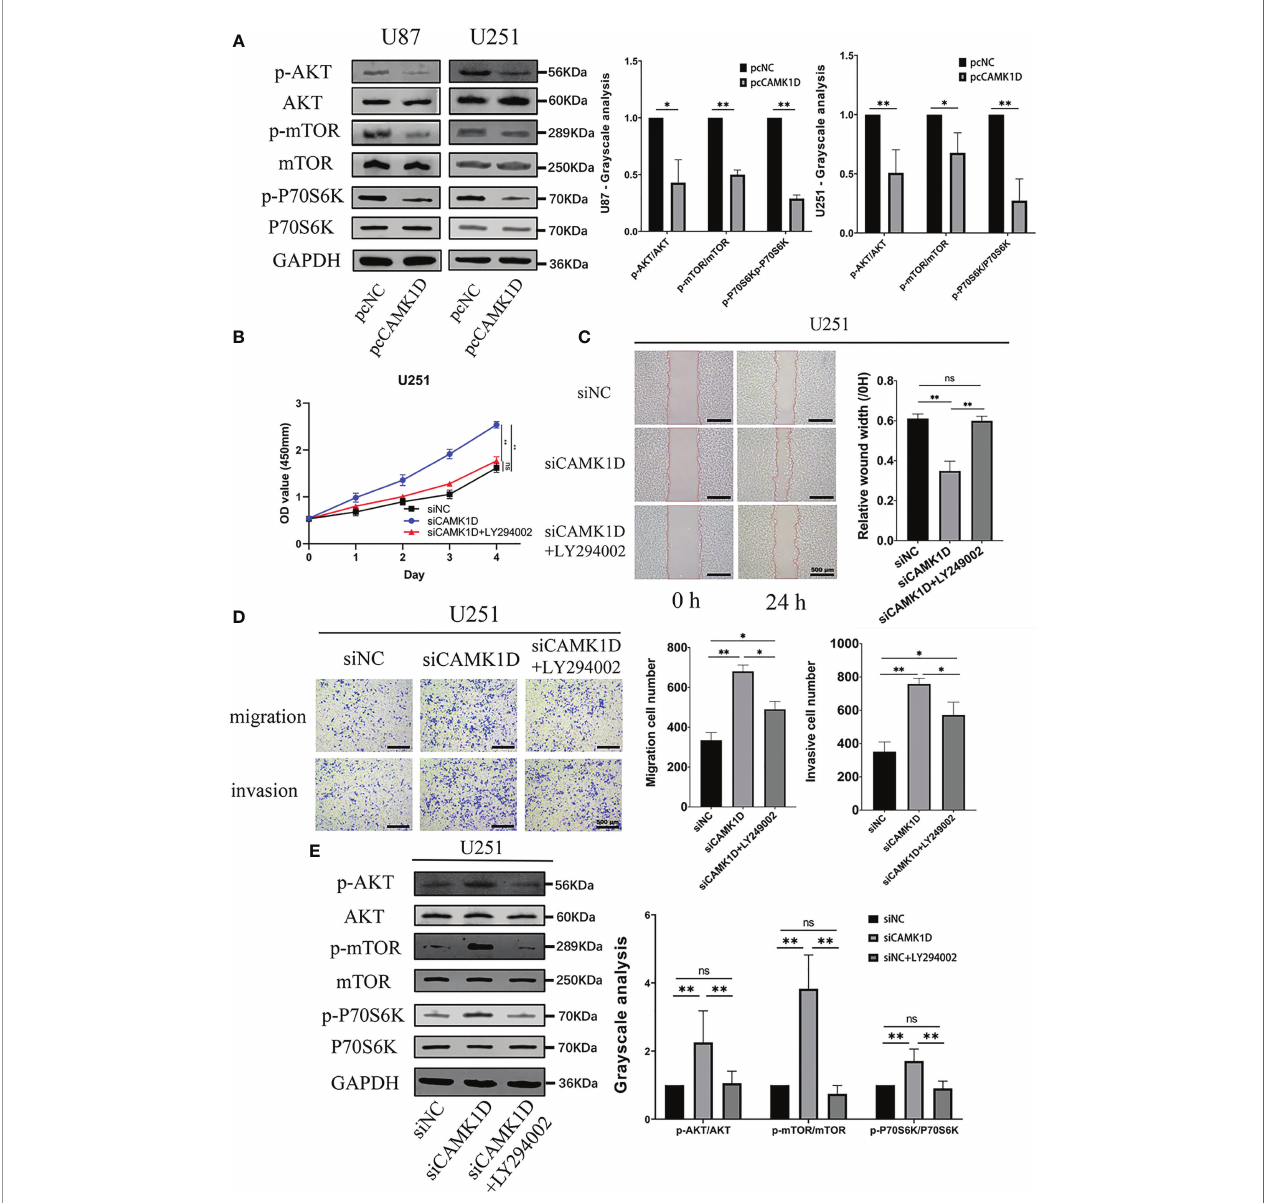
FIGURE 7 | CAMK1D level changes on the PI3K/AKT/mTOR pathway. (A) Compared with the control, the expression of p-AKT and p-mTOR was signi fi cantly decreased after CAMK1D overexpression using pcCAMK1D plasmid construction in U87 and U251 cells. (B – D) LY294002 reversed the increases in cell proliferation, migration, and invasion induced by the decrease in CAMK1D using siCAMK1D in U87 and U251 cells. (E) LY294002 reversed the decrease of p-AKT and p-mTOR expression by siCAMK1D. ns, no signi fi cance; * p < 0.05; ** p <